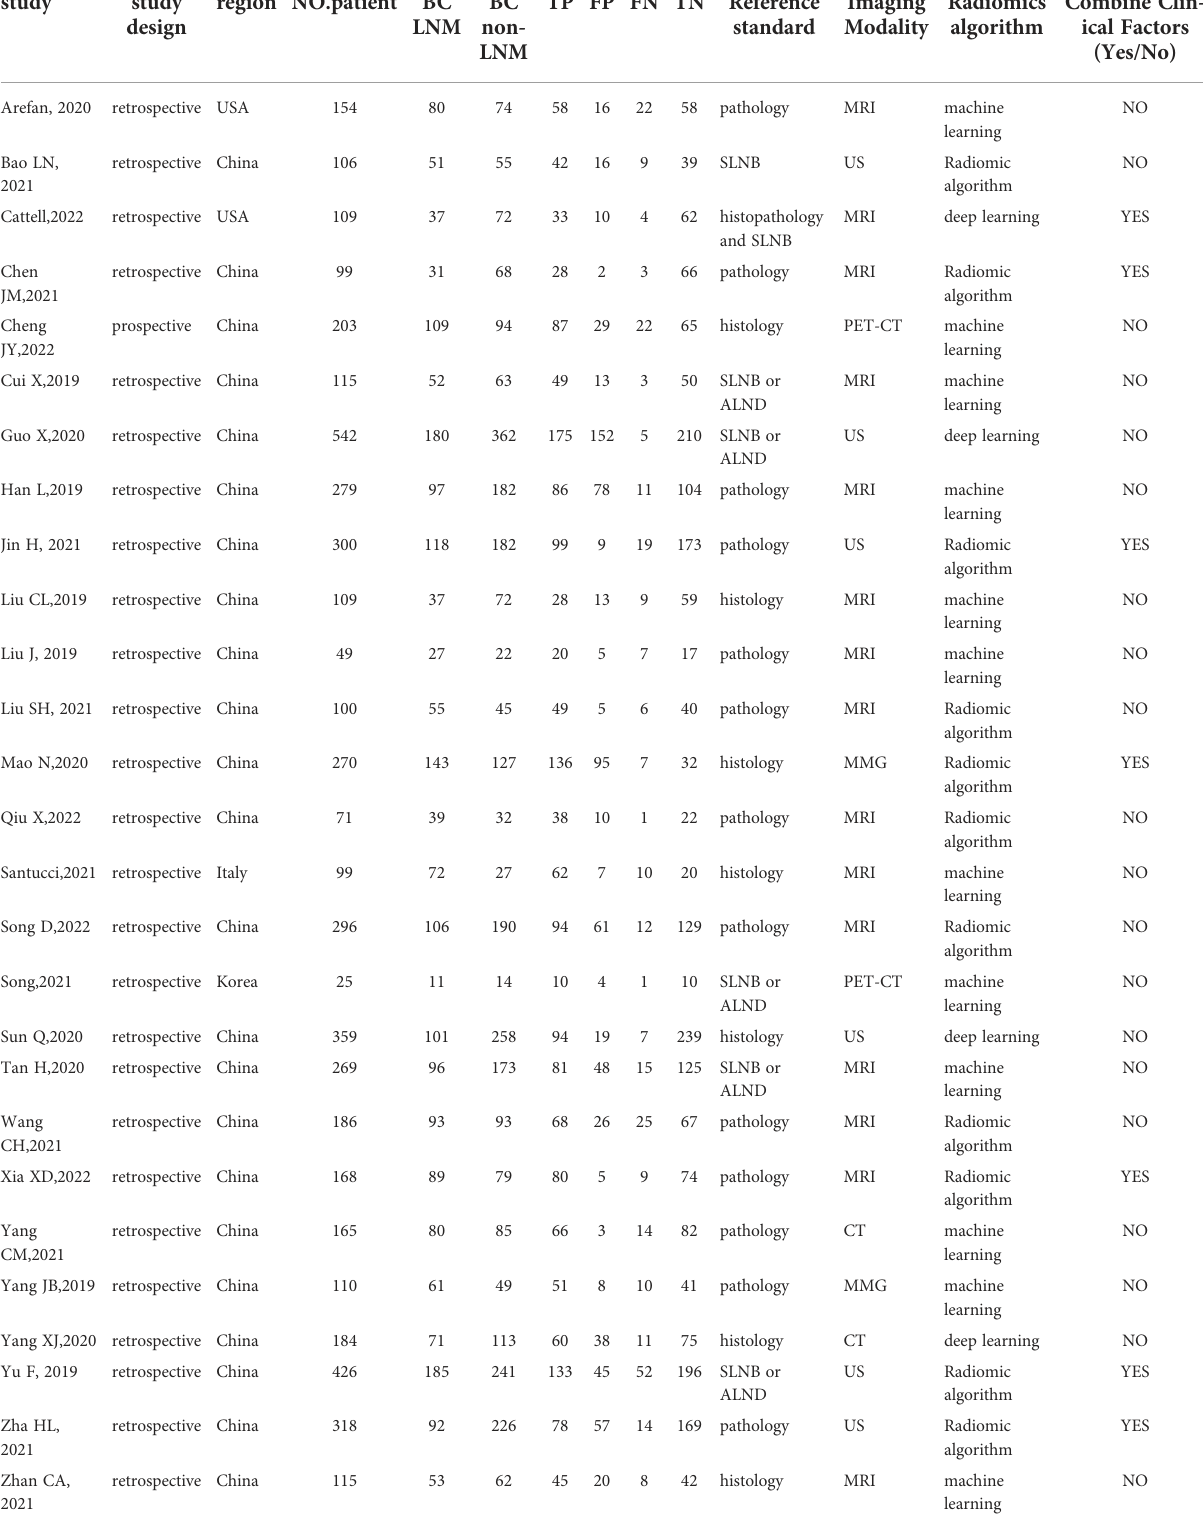
TABLE 1 The baseline characteristics of included